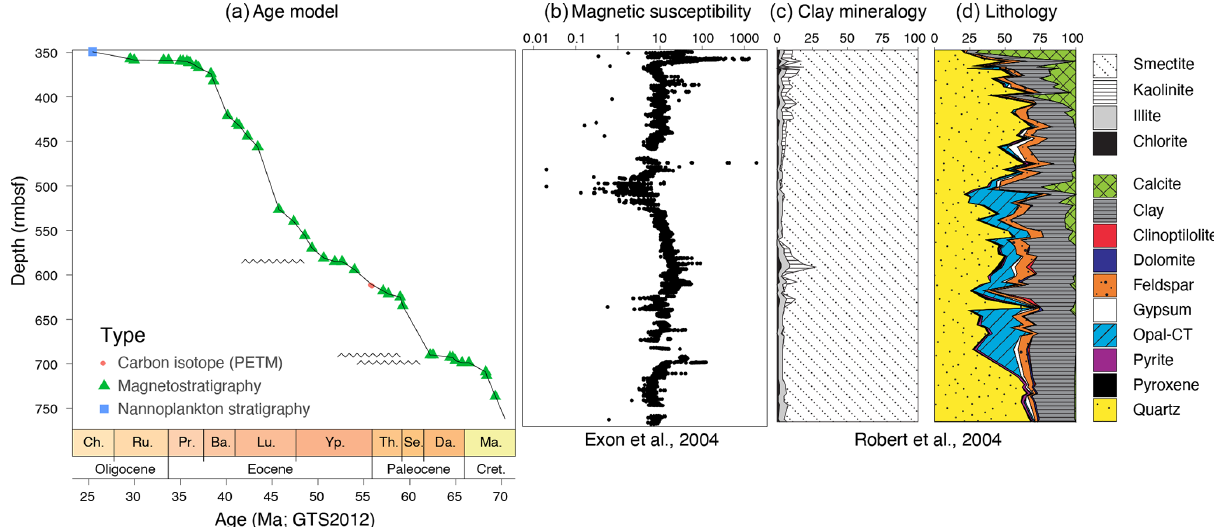
Figure 2. (a) Age tie points used to construct the age model for ODP Site 1172, based on stable carbon isotopic (red dot; Sluijs et al., 2011), magnetostratigraphic (green triangles; Stickley et al., 2004a; Bijl et al., 2010; Houben et al., 2019) and nannofossil (blue square; Houben et al., 2019) age constraints. Black wobbly lines represent hiatuses. (b) Shipboard magnetic susceptibility from Exon et al. (2001). (c) Clay mineralogy and (d) smear slide-based lithological observations from Robert